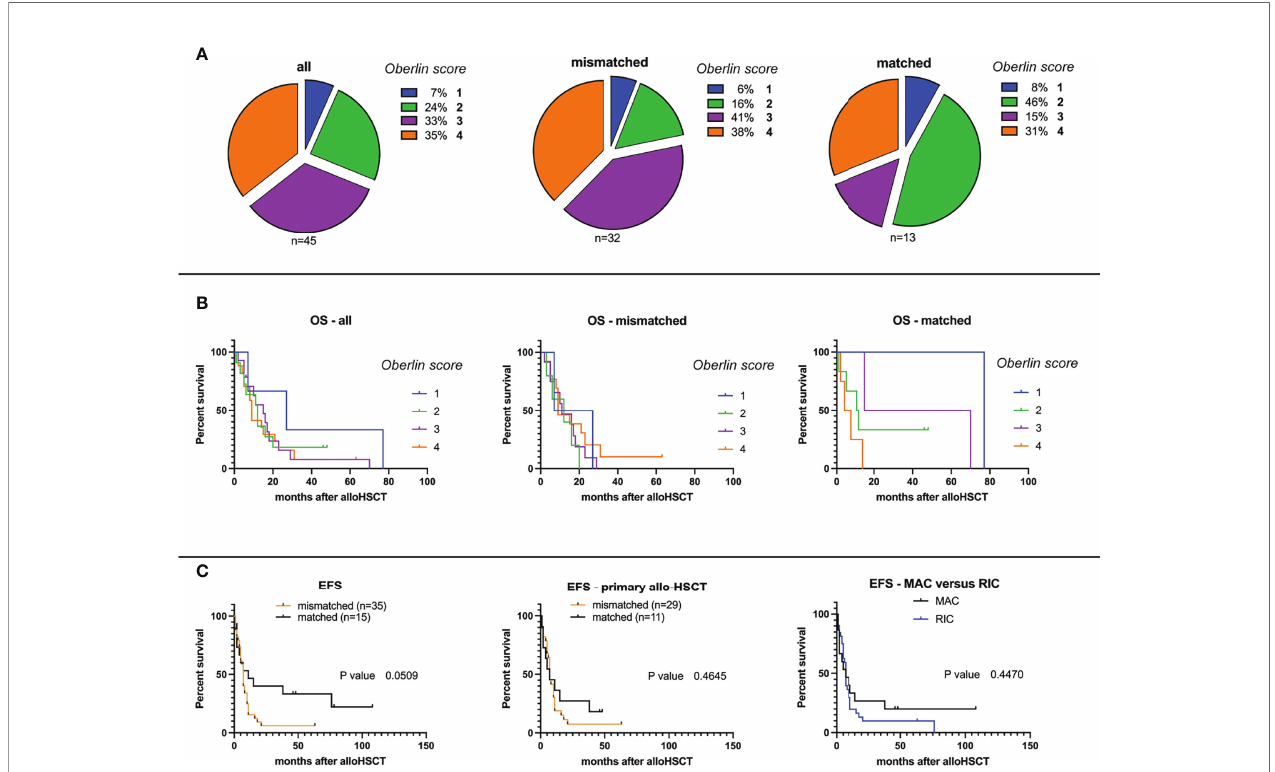
FIGURE 1 | (A) Overall and event-free survival probabilities according to Oberlin score, HLA-mismatch/match, and conditioning regimen. Distribution of Oberlin risk factors (0 – 4) within study groups for HLA-mismatched and -matched analyses. (B) Overall survival (OS) probabilities after allogeneic hematopoietic stem cell transplantation (allo-HSCT) within study group population: all, HLA-mismatched, and HLA-matched (from left to right). (C) Event-free survival (EFS) probabilities after allo-HSCT for HLA-mismatched versus -matched grafts for all transplanted patients (left), primarily allo-transplanted patients (middle), and separated by myeloablative (MAC) or reduced-intensity conditioning (RIC,